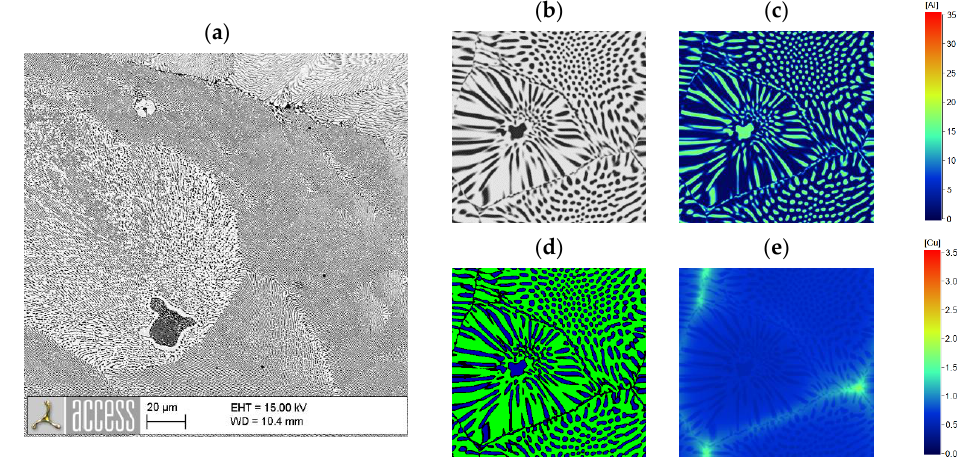
Figure 6. ( a ) Microstructure of ZnAl5.5Cu0.7 in BSE contrast; ( b – e ) simulated microstructure of ZnAl5.5Cu0.7. ( b ) Al (gray scale, matched contrast), ( c ) Al concentration (wt.%), ( d ) phases (η green, β blue) and ( e ) Cu concentration (wt.%). Size of the 2D plane from the simulation: 100 µm × 100 µm.